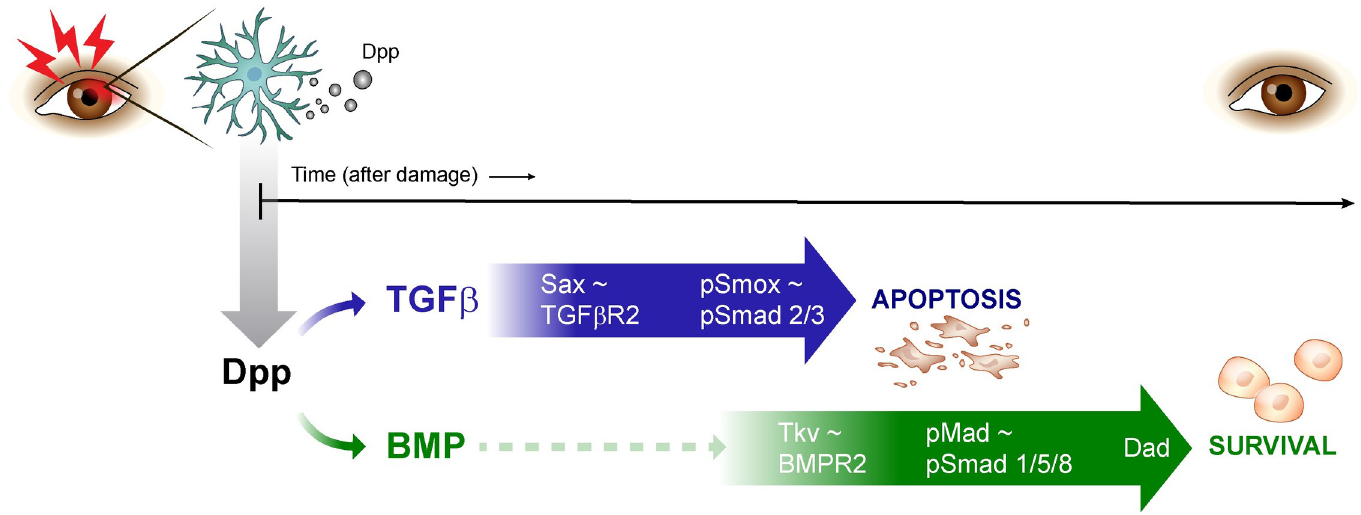
Fig 5. Cartoon depicting the role of Dpp and TGF β /BMP signaling as central controllers of photoreceptor death and survival after acute damage within the retina. Based on our data, under immune cell secreted Dpp/TGF β /BMP ligand activation, Sax/pSmox ~ TGF β R2/pSmad2/3 activate first driving retinal apoptosis, followed by Tkv/pMad ~ BMPR2/pSmad 1/5/9 promoting increased retinal survival post-injury.